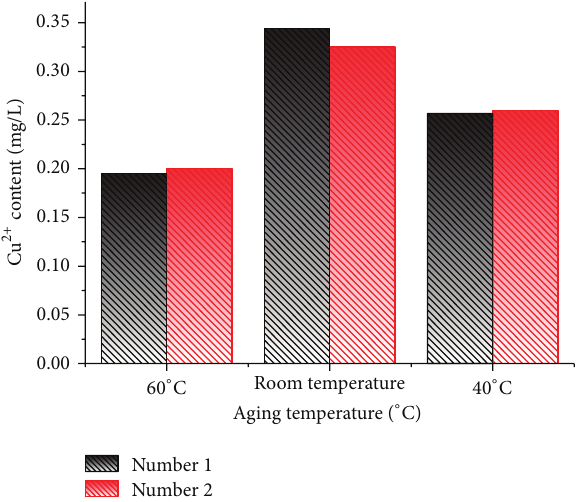
Figure 5: Effect of aging temperature on removal of copper.